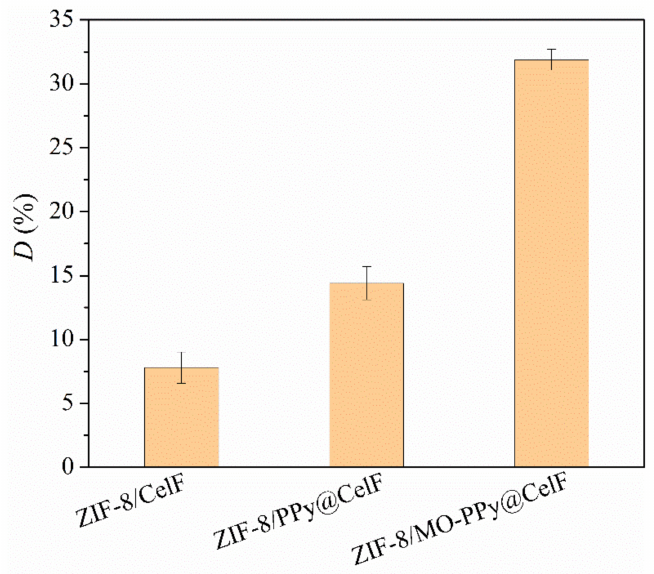
Figure 1. Comparison of ZIF-8 growth on three CelF substrates. Process conditions: 25 ◦ C, Py 1 mL, Zn(NO 3 ) 2 12 mmol, 6